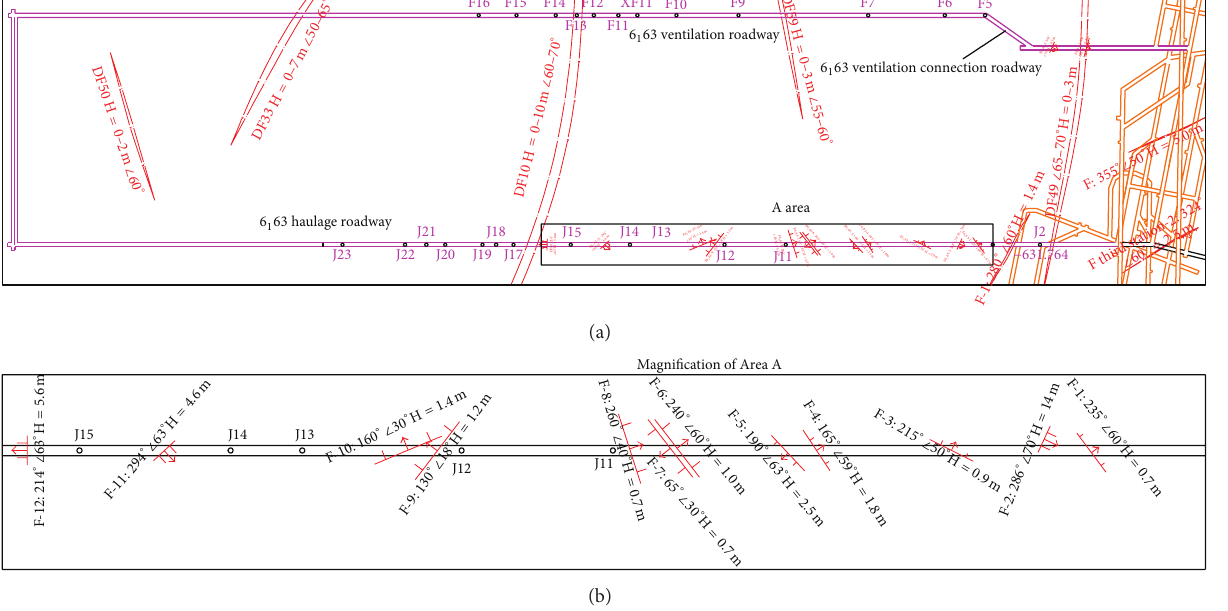
Figure 1: Layout of haulage roadway 6 1 63 and geological conditions around. (a) General view of the roadway; (b) expanded view of Area A.